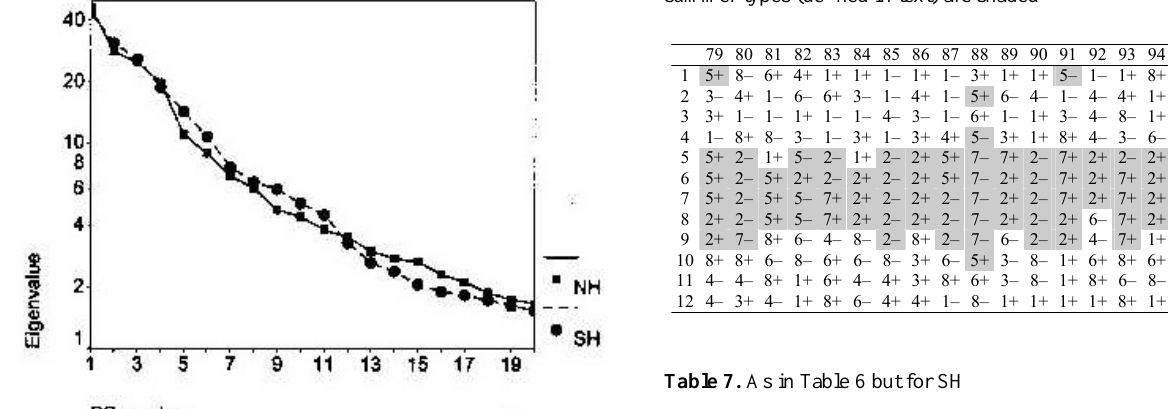
Table 6. As in Table 1 except for 8 rotated PCs of anomalies. The summer types (defined in text) are shaded